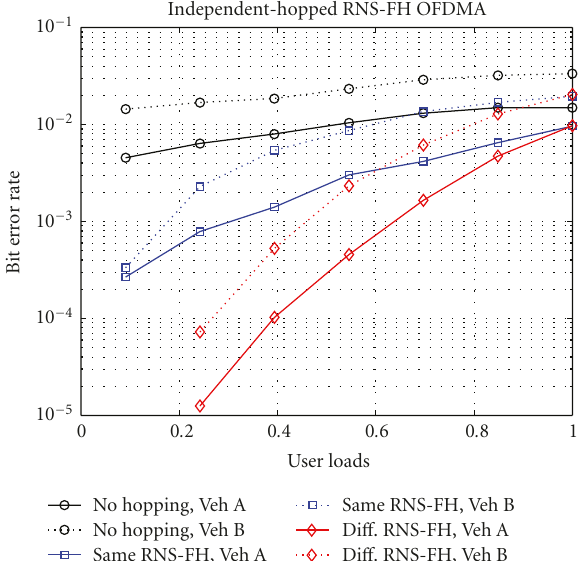
Figure 12: BER versus user loads of RNS-FH OFDMA under independent hopping with di ff erent channel conditions, N = 110, M = M c = 10, N c = 11, SNR = 25 dB, SIR = 15 dB, f D T s = 0 . 01.